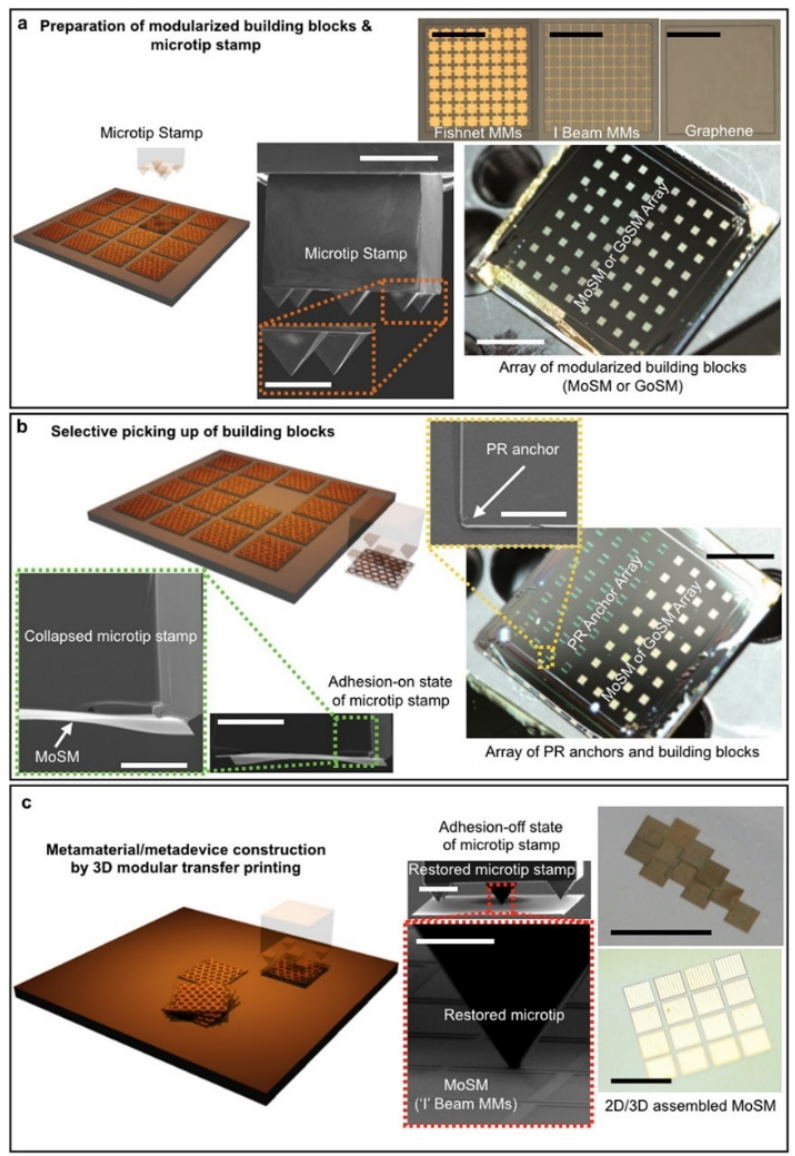
Figure 7. Heterogeneously integrated metamaterial/metadevice assembly on universal substrates by 3D modular transfer printing: ( a ) modularized basic building blocks preparation, ( b ) metamaterials on a silicon membrane (MoSM) and graphene on a silicon (GoSM) picking up by the 5-microtip stamp. ( c ) Three-dimensional modular transfer printing used to fabricate a metamaterial/metadevice. Two-dimensional and three-dimensional metamaterials and metadevices by assembling each individual building lock (i.e., MoSM or GoSM). (Reprinted with the permission of Copyright © 2018, Springer International Publishing AG).